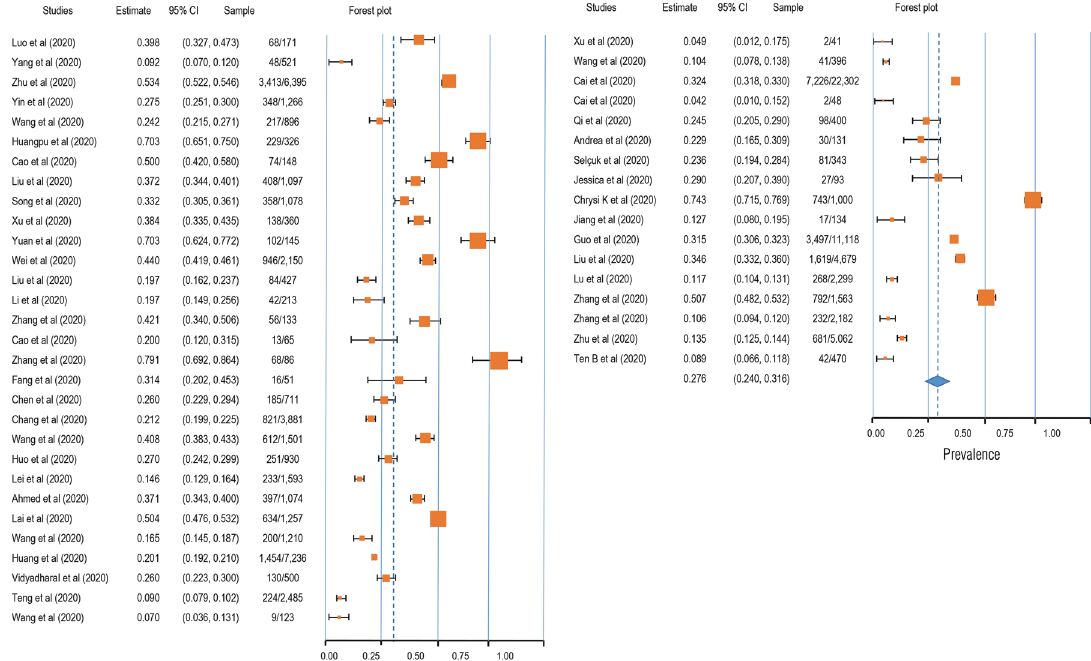
Fig. 3 Forest plot for meta-analytic results of the prevalence of depression symptoms. The squares colored by orange represent the point estimation foreffect towards corresponding study, with the large square size for high effect size. The orange diamond represent meta-analytic effect